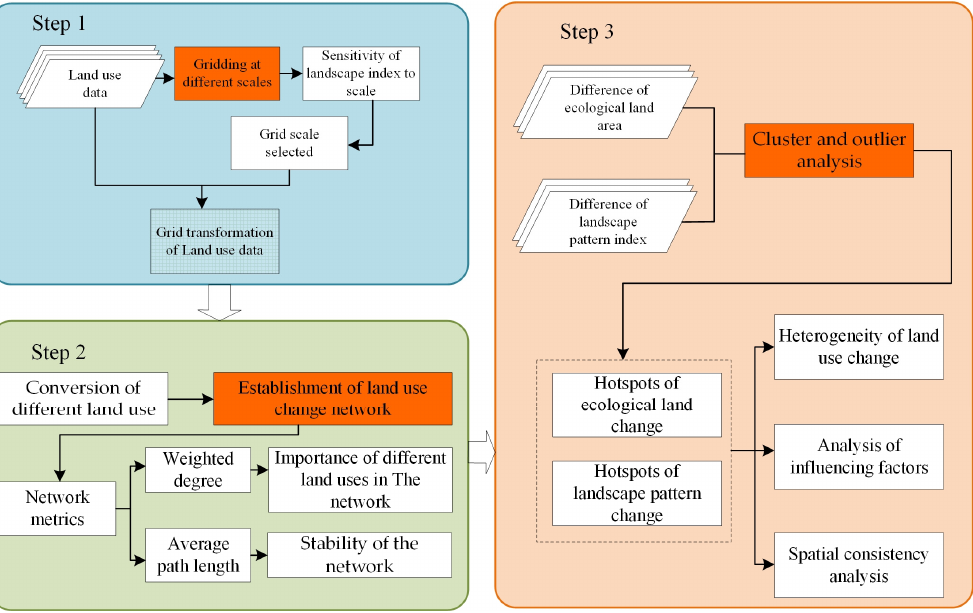
Figure 3. Overall workflow of the land use change and hotspot analysis of the urban agglomeration .